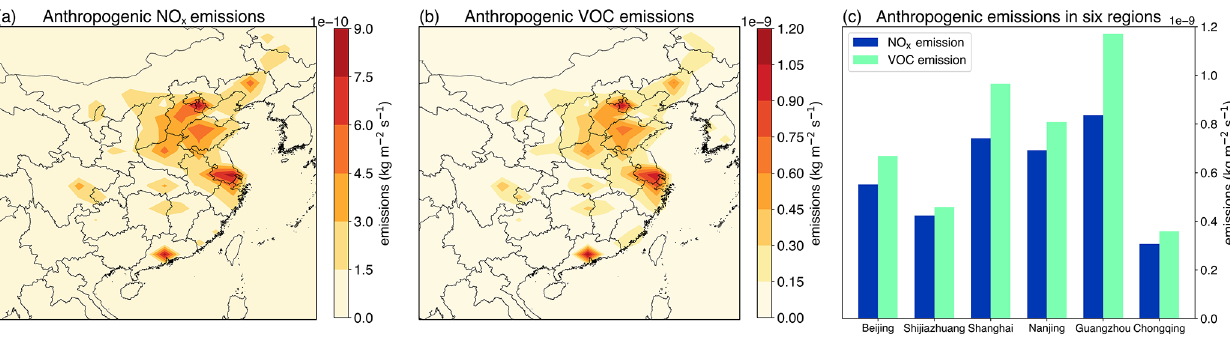
Figure 2. Spatial distributions of anthropogenic NO x and VOC emissions (kgm − 2 s − 1 ) across China (a, b) and grid-weighted averaged emissions for the six regions within the four major industrialised regions (c) in JJA,